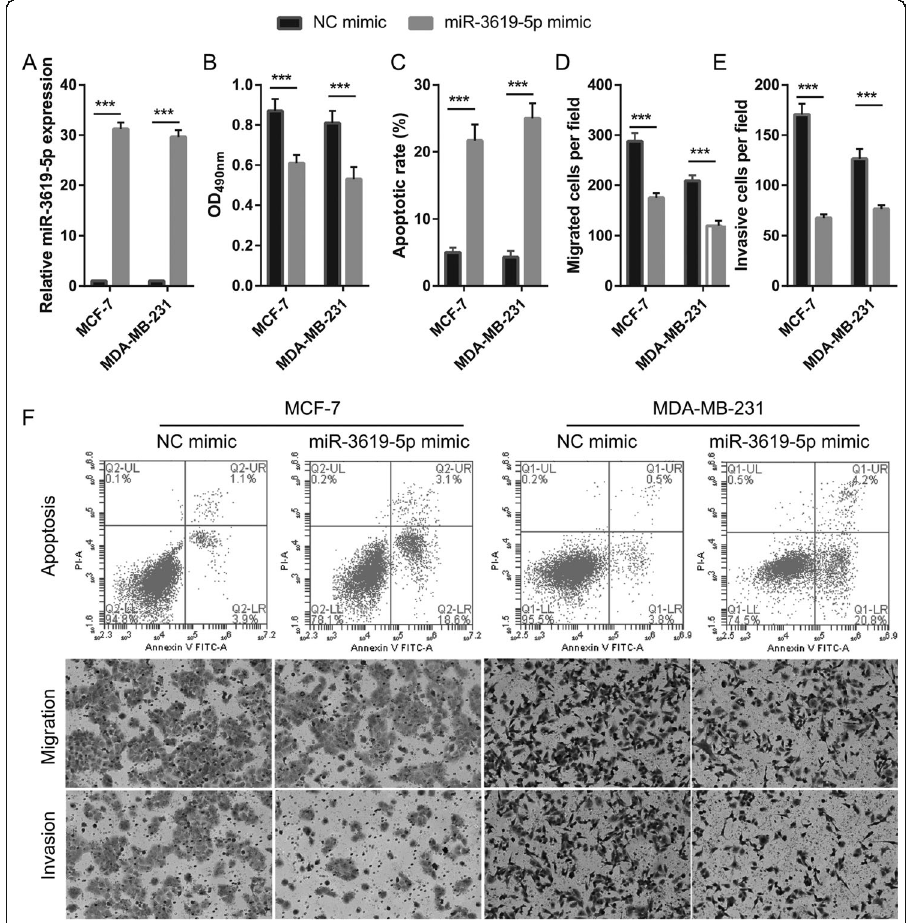
polymerase chain reaction (qRT-PCR) analysis at 48 h after transfecting the miR-3619-5p mimic. b – e Proliferation, apoptosis, migration, and invasion of BC cells measured by performing 3-(4,5-dimethylthiazol- 2-yl)-2,5-diphenyltetrazolium bromide (MTT) assays, flow cytometry, transwell migration assays, and invasion assays, respectively. The data shown are the mean ± standard deviation (SD). f Representative images showing cell apoptosis, migration, and invasion. *** P <